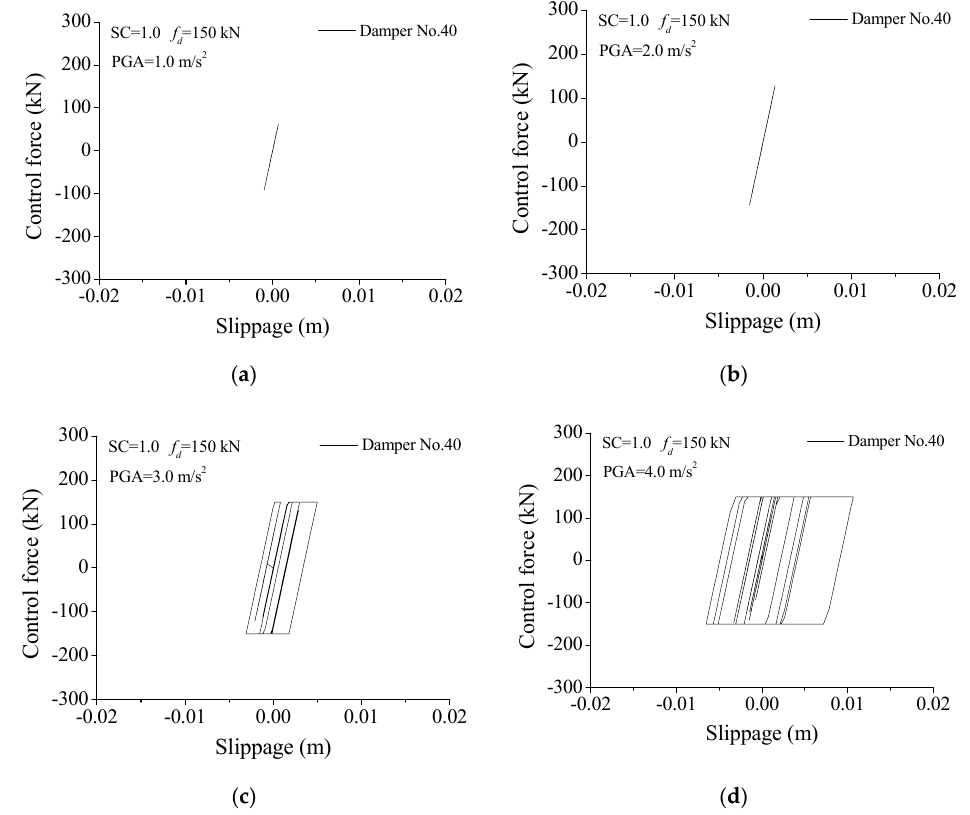
Figure 16. Hysteresis loops of friction dampers under different earthquake intensities. ( a ) PGA = 1.0 m/s 2 ; ( b ) PGA = 2.0 m/s 2 ; ( c ) PGA = 3.0 m/s 2 ; ( d ) PGA = 4.0 m/s 2 .